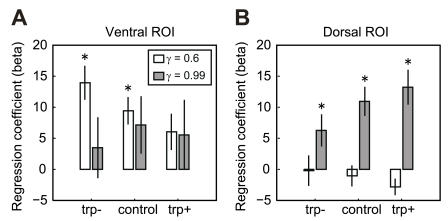
Effects of tryptophan levels on short- and long-term reward prediction in ventral and dorsal parts of the striatum.Bar plots show the regression coefficients (betas) of V(t) with γ = 0.6 (white bars) and 0.99 (gray bars) for the BOLD signals in the regions of interest (ROI) in the ventral (A) ((x, y, z) = (26, 0, −4) and (−26, 0, −8); see Table S2) and dorsal (B) ((x, y, z) = (24, 2, 22) and (−16, 2, 28)) parts of the striatum. Data shown are group averages (n = 12 subjects), and error bars represent standard errors. * significantly different from zero at P<0.05 in a two-tailed one sample t-test.